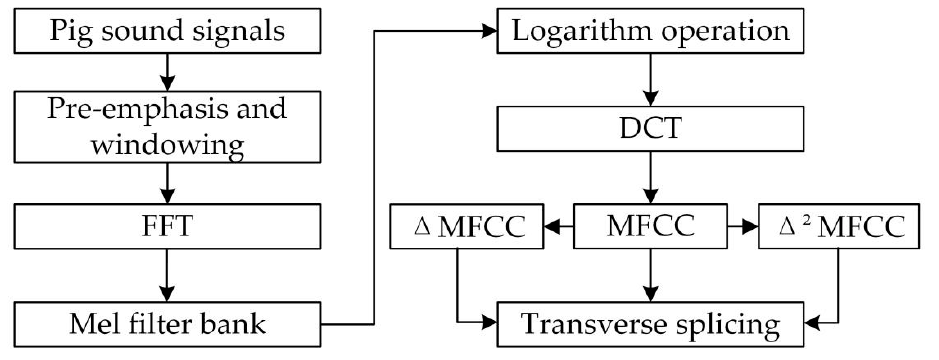
Figure 5. MFCC parameter extraction process.